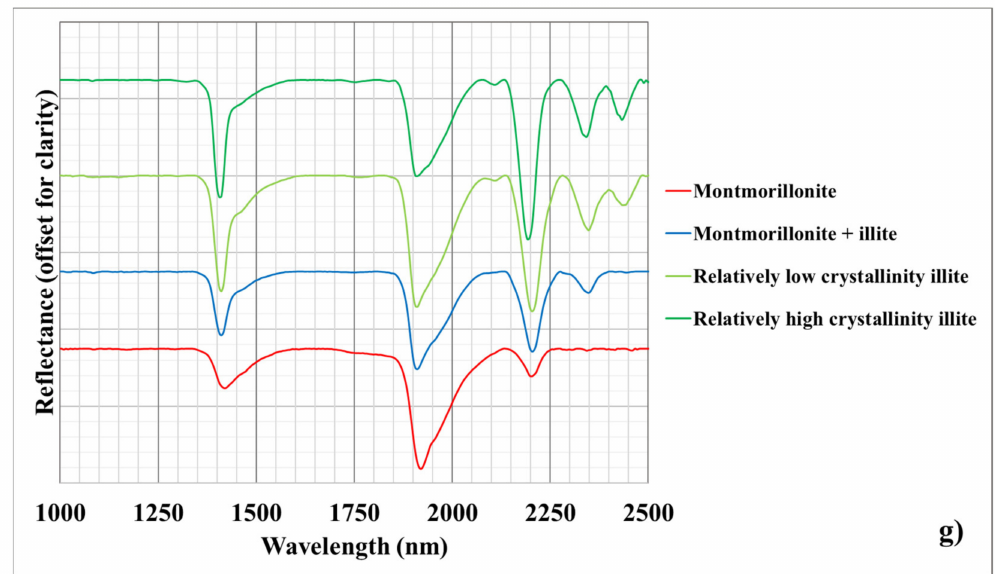
Figure 2. Natural color of samples S08 ( a ) and S06 ( b ). Mineral maps and semi-quantitative mineral abundances in surface area percentage for the weathered surface of S08 ( c ). A/A (cid:48) shows the cutting location of the rock sample and S06 ( d ), and the freshly cut surface of S08 ( e ) and S06 ( f ). Average hull removal SWIR spectra of rock samples in both weathered and freshly cut surfaces ( g ). Abbreviations based on Whitney and Evans [20]. Ilt = illite; Mnt =